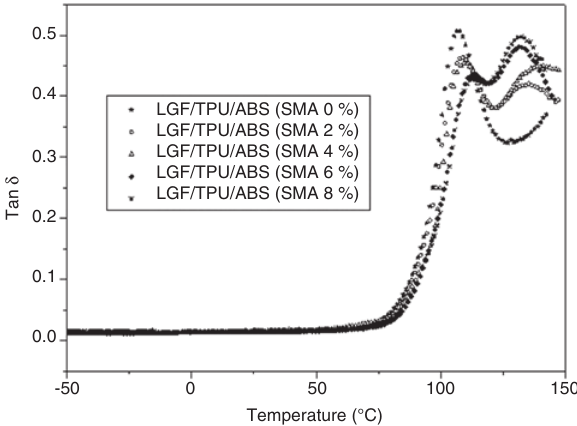
Figure 5 TGA thermograms of the composites at various compatibi- lizer content.